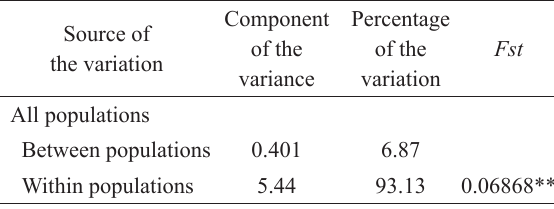
Analysis of molecular variance (AMOVA) of the four populations of C. macropomum (Amazon and Curuá-Una rivers, breeding stock, and fish farms) analyzed in the present study.